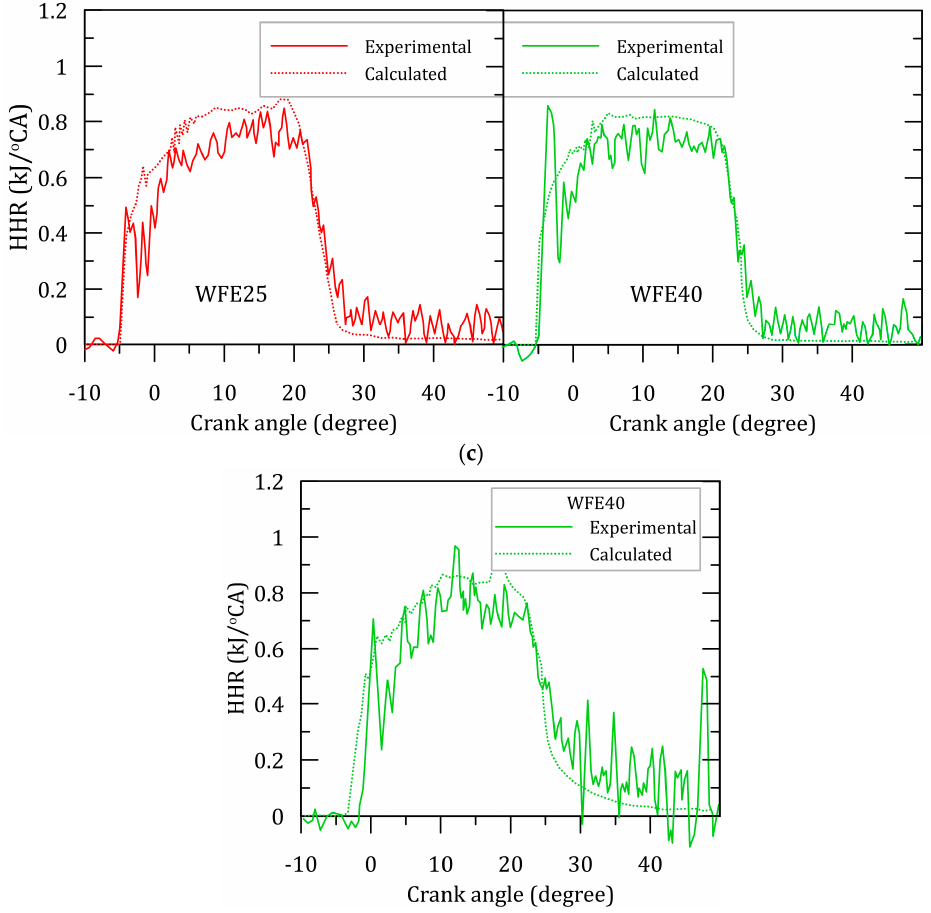
Figure 12. Heat release rate versus crank angle in both experiment and calculated cases: ( a ) the heat release rate for: ( a ) the gas oil as a base case, ( b ) the duration case, ( c ) the pressure case, and ( d ) the diameter case.